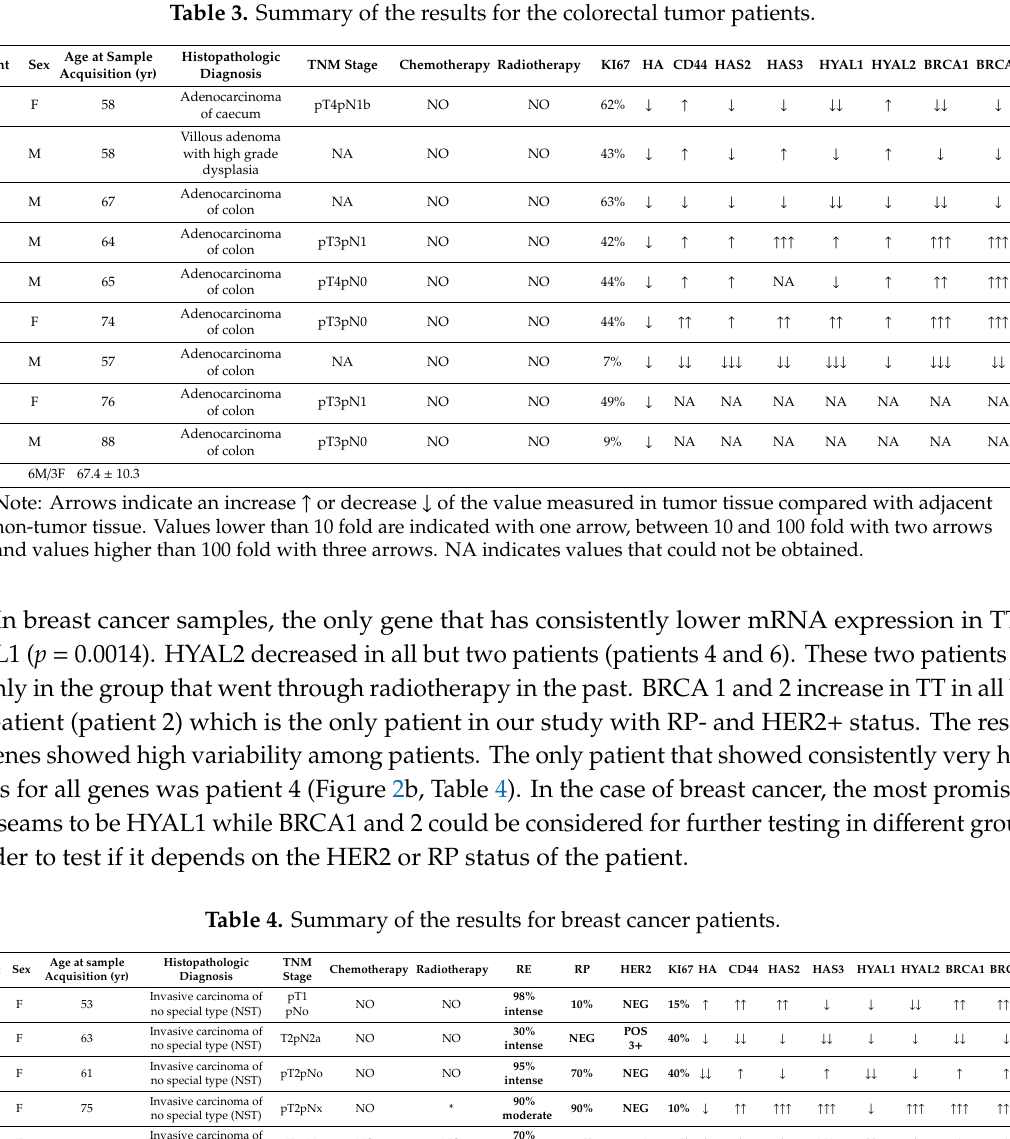
Note: Arrows indicate an increase ↑ or decrease ↓ of the value measured in tumor tissue compared with adjacent non-tumor tissue. Values lower than 10 fold are indicated with one arrow, between 10 and 100 fold with two arrows and values higher than 100 fold with three arrows. NA indicates values that could not be obtained. * indicates patients who underwent therapy in the past for another disease (patient 4, 25 years ago and patient 6, 8 years